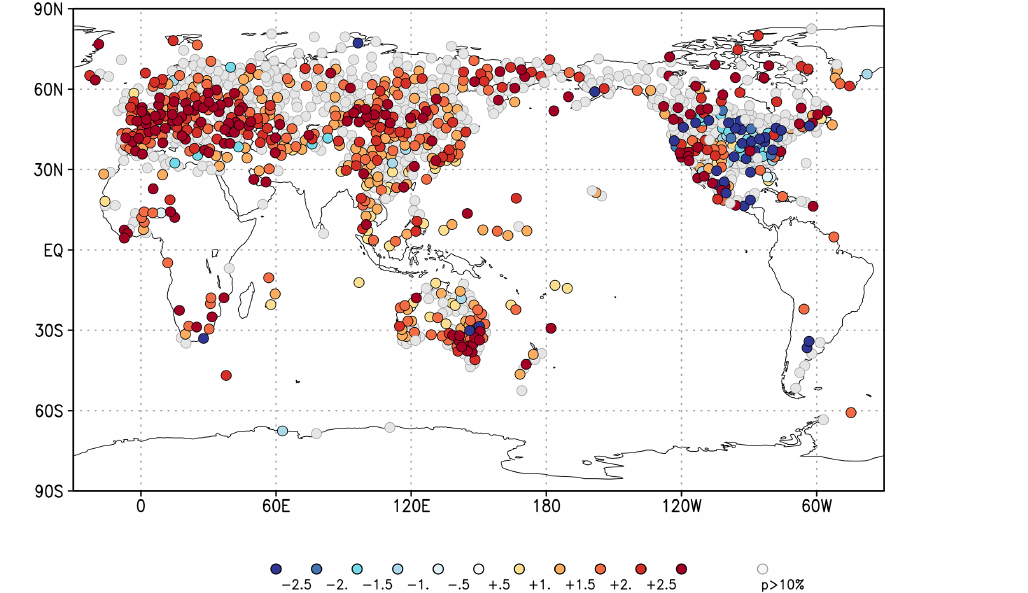
Figure 3. Trends in the highest daily maximum temperature of the year in the GHCN-D station data. Stations are selected to have at least 50 years of data and to be at least 2 ◦ apart. The local trends are defined by their regression on the global mean temperature and shown in units of multiples of the global mean temperature rise. Source: GHCND (Menne et al.,